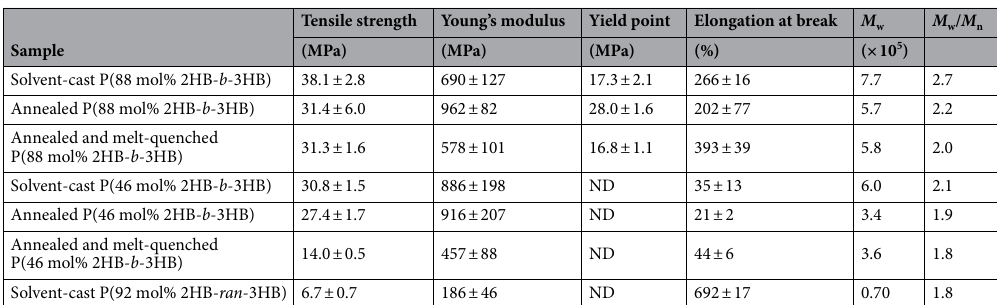
Table 3. Mechanical properties and molecular weights of P(2HB- ran -3HB) and P(2HB- b -3HB). M w = weight- average molecular weight. M n = number-average molecular